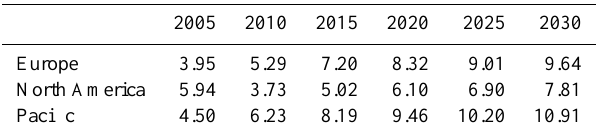
Table 4. Gas prices in the IEA-WEO (2009) Reference scenario in Euro GJ − 1